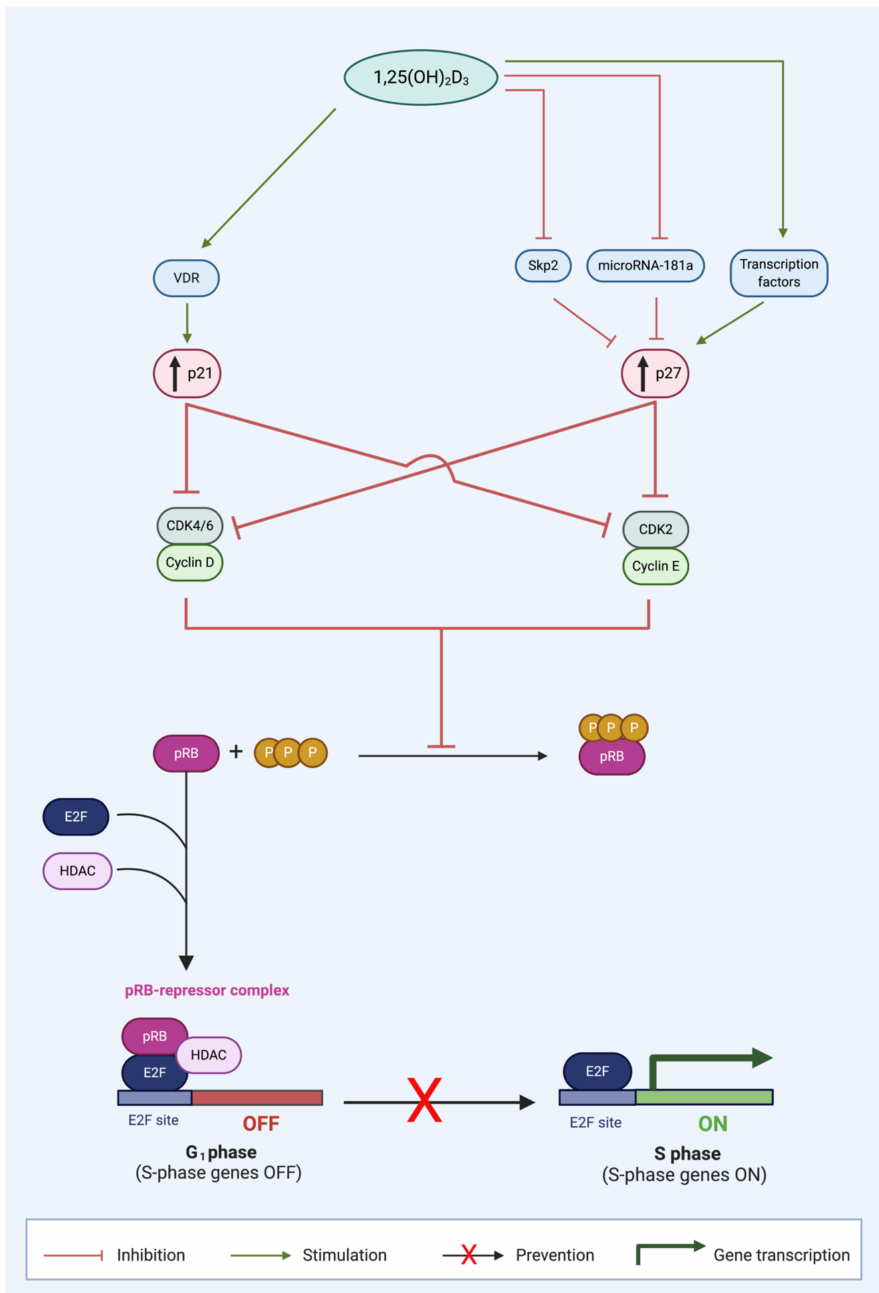
Figure 2. Calcitriol upregulates p21 and p27 expression in the G1 phase and prevents cell cycle progression to the S phase [3]. Calcitriol (1,25(OH) 2 D 3 ) increases the expression of CDK inhibitors (CDKIs), p21 and p27, by numerous mechanisms. p21 expression is increased by stimulation of liganded VDR signaling. p27 expression is increased by signaling transcription factors; inhibition of p27 protein degradation by S-phase kinase-associated protein 2 (Skp2); and enhanced p27 translation by abrogated microRNA-181a expression. The collective outcome of the increased CDKI expression is suppression of cyclin-CDK complex formation, which inhibits the formation of hyperphosphorylated retinoblastoma protein (pRB). The unphosphorylated pRB thus is able to form a repressor complex with histone deacetylase (HDAC) and E2F transcription factor (E2F), which prevents the progression of cancer cells in the G1 phase to the S phase, inhibiting S phase gene expression, and thus causing G0 / G1 cell cycle arrest. (Source: personal